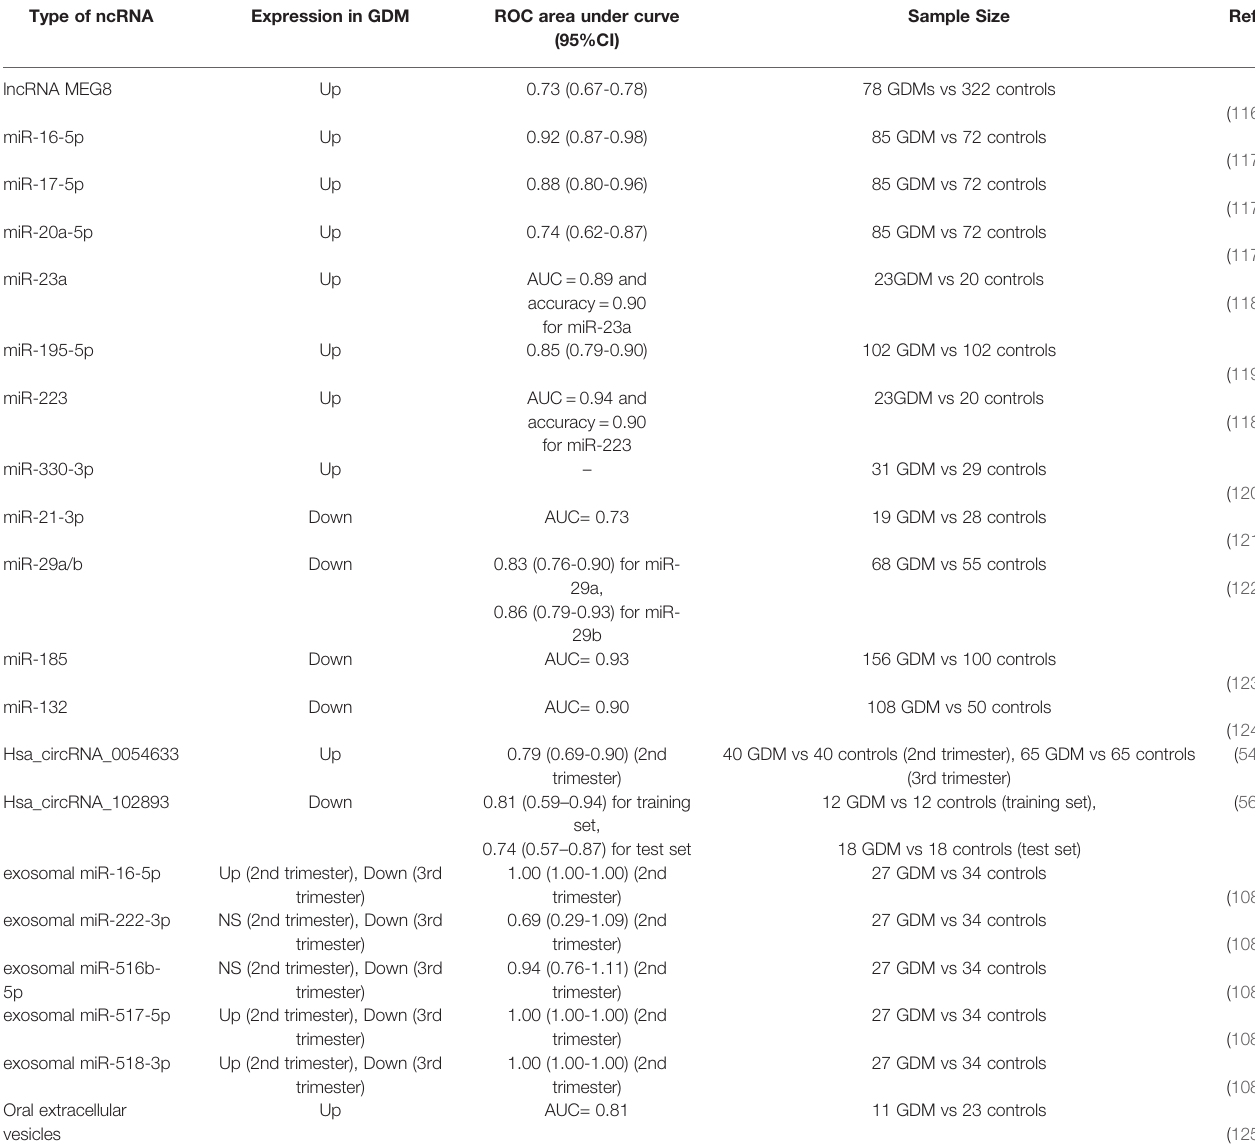
TABLE 4 | Selected ncRNAs as biomarkers for